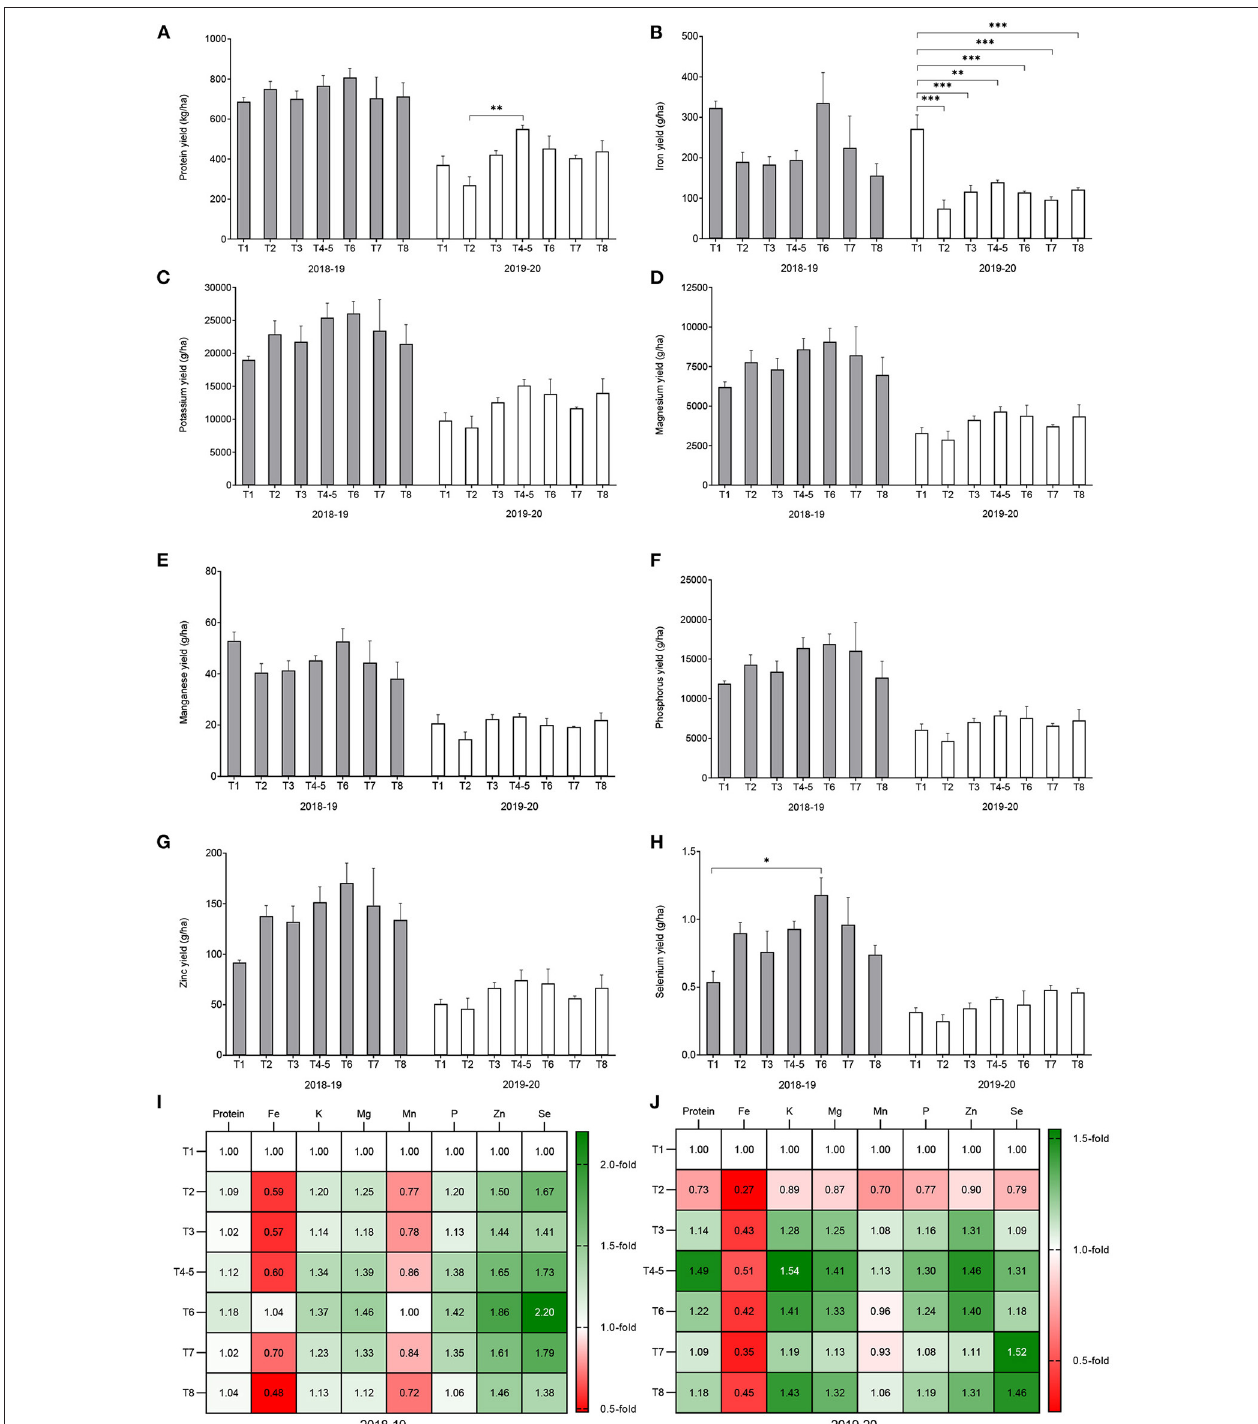
FIGURE 6 | Effect of conservation agriculture on nutrient yield of maize variety DKC 9089 during two seasons of field trials. Error bars represent SEM. *, **, and *** mean, significant at 0.05, 0.01, and 0.001, respectively, Tukey’s HSD test. Values in Figures 5J,K are the number of fold-change compared to treatment T1 (conventional practise). Treatments: T1 = conventional agriculture; sole maize. T2 = conservation agriculture (CA); basin sowing; sole maize. T3 = CA; dibble stick sowing; sole maize. T4–5 = CA; dibble stick sowing; maize-cowpea rotation. T6 = CA; dibble stick sowing; maize-pigeon pea intercrop. T7 = CA; dibble stick sowing; maize-cowpea intercrop. T8 = CA; dibble stick sowing; maize-velvet bean intercrop.